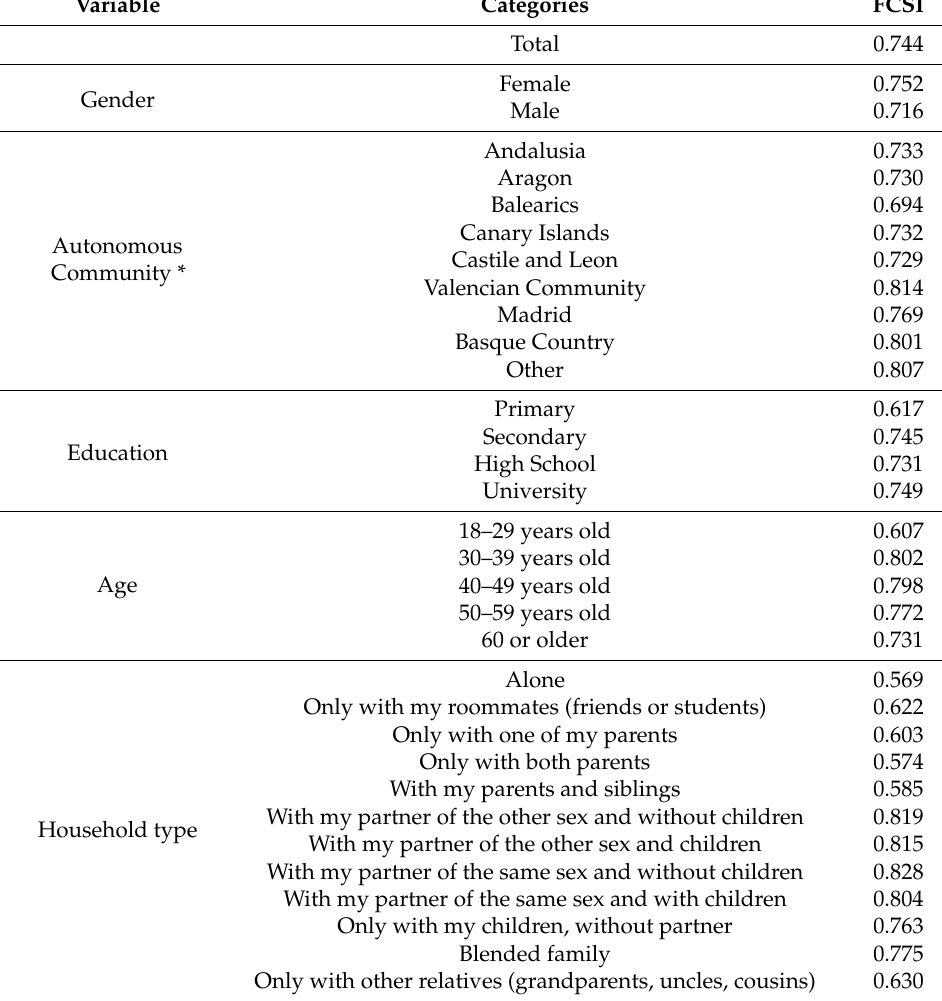
Table 6. Family climate synthetic